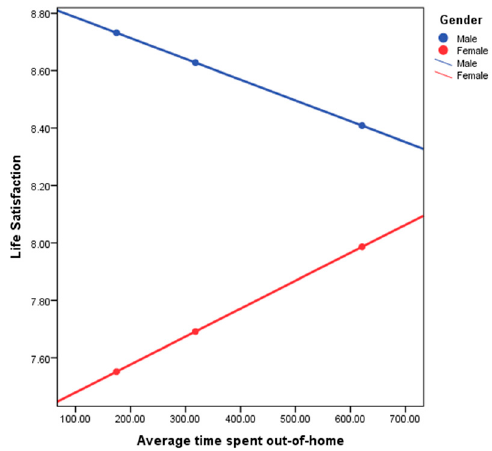
Figure 1. Life satisfaction with time spent out-of-home moderated by Male/Female.